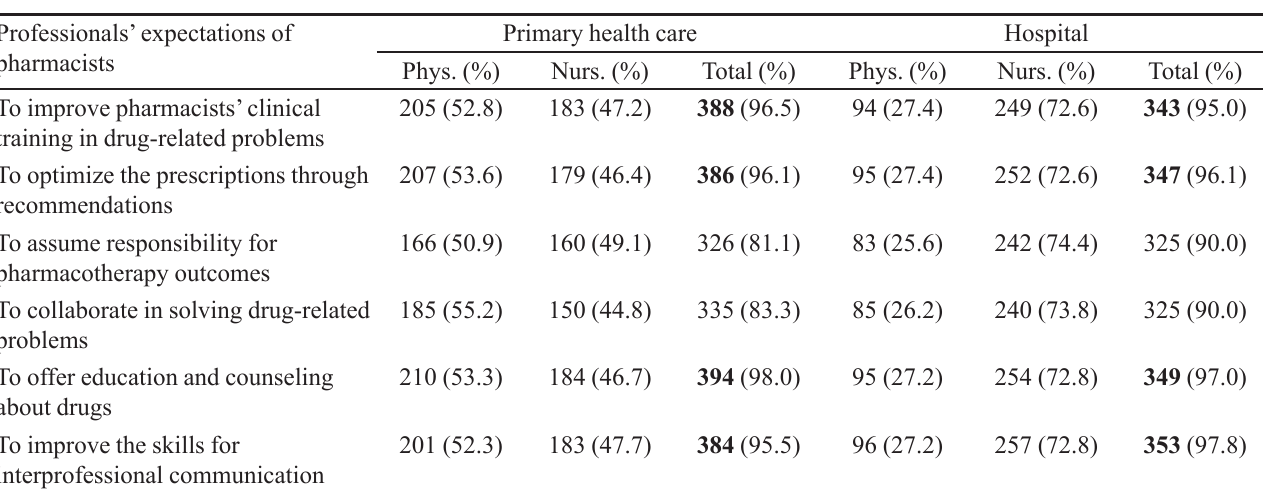
TABLE IV - Professionals’ expectations of pharmacists’ role Professionals’ expectations of